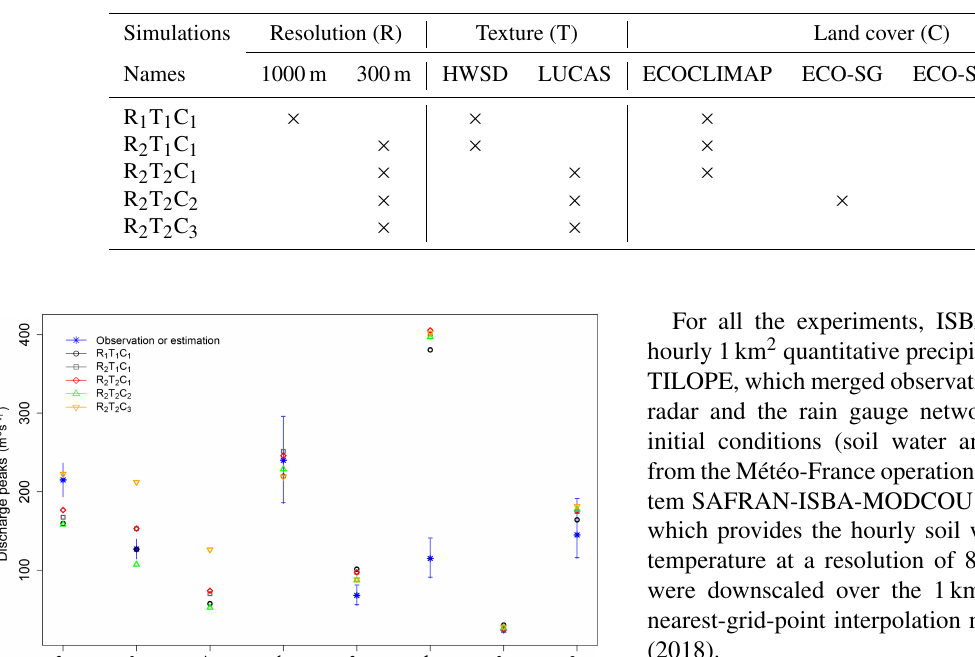
Table 4. Experimental parameters.